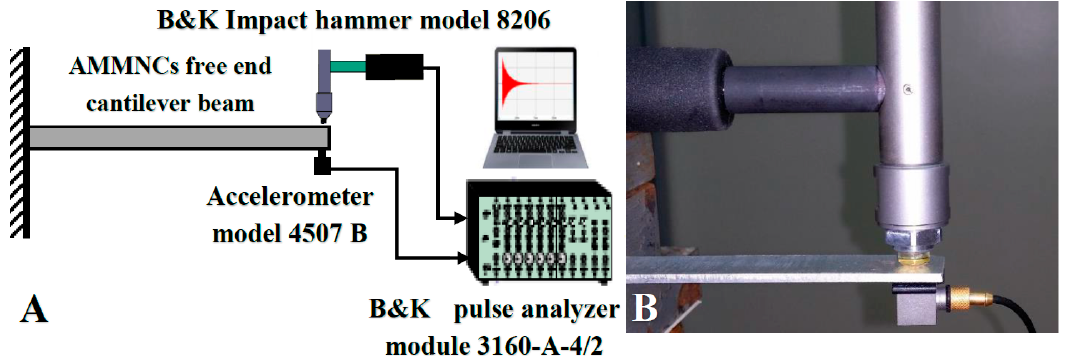
Figure 5. ( A ) Schematic diagram for the experimental setup of free vibration tests; ( B ) typical test rig and the equipment used in free vibration test.